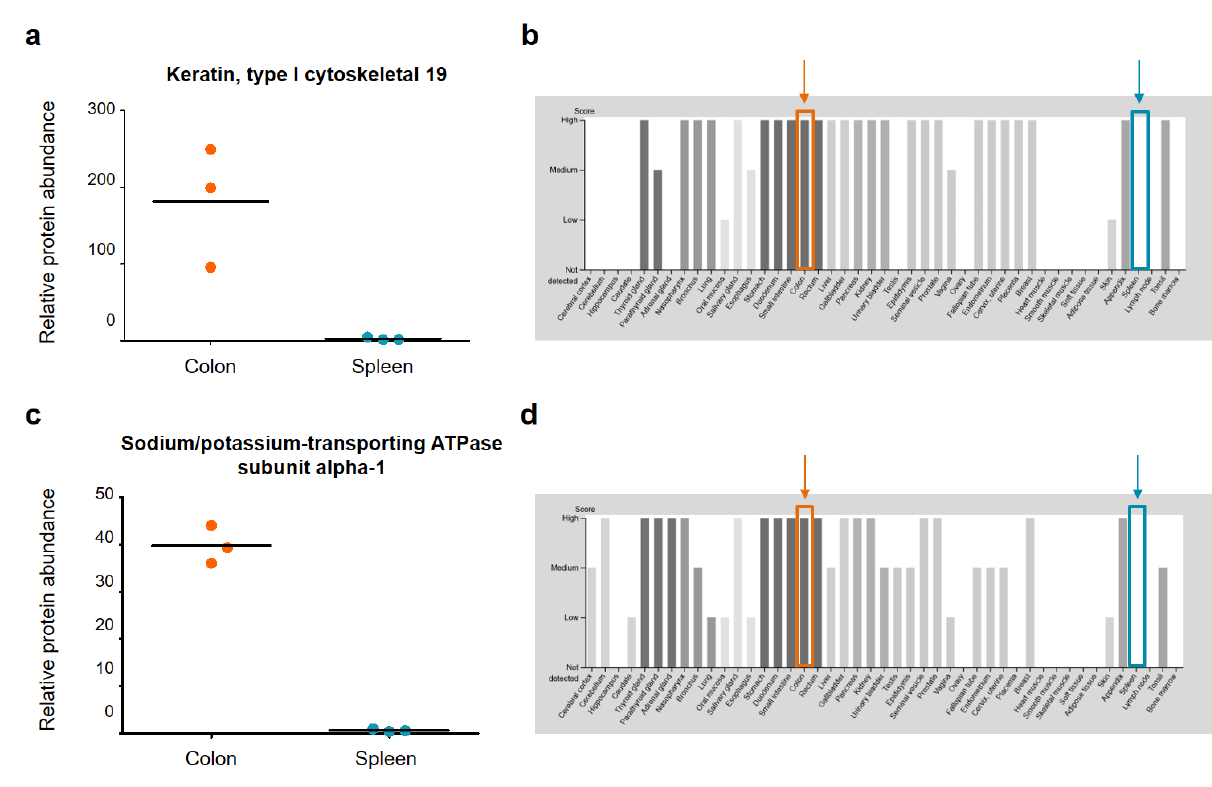
Figure 7. Relative protein abundance plots for ( a ) keratin, type I cytoskeletal 19 (Krt19) and ( c ) sodium/potassium- transporting ATPase subunit alpha-1 (Atp1a1) in murine colon and spleen samples. The corresponding protein abundance data of the Human Protein Atlas (HPA) [30] is shown in ( b ) for Hba and ( d ) for Cotl1. A total of 44 different tissue types were examined for the protein abundance data of the HPA. The data in ( a – d ) is highlighted in orange for colon tissue and in blue for spleen tissue. Images ( b , d ) are available from